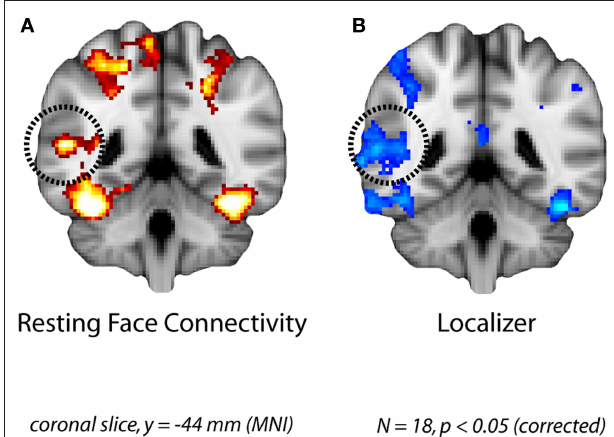
FIguRe 3 | Face-specific connectivity from experiment 2. (A) Group analysis of resting correlations with each subject’s face-specific FG after removing variance from their scene-specific PHC. (B) The pSTS region that was correlated with the FG at rest overlapped with the face-selective pSTS region obtained in a group analysis of the localizer runs.